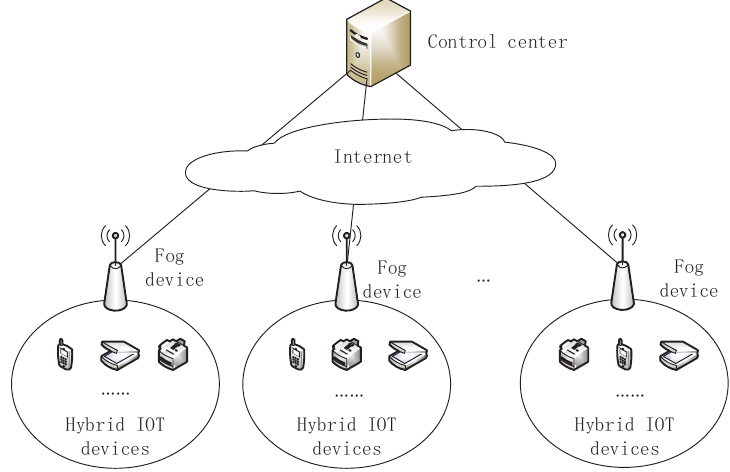
Figure 1. The system model of